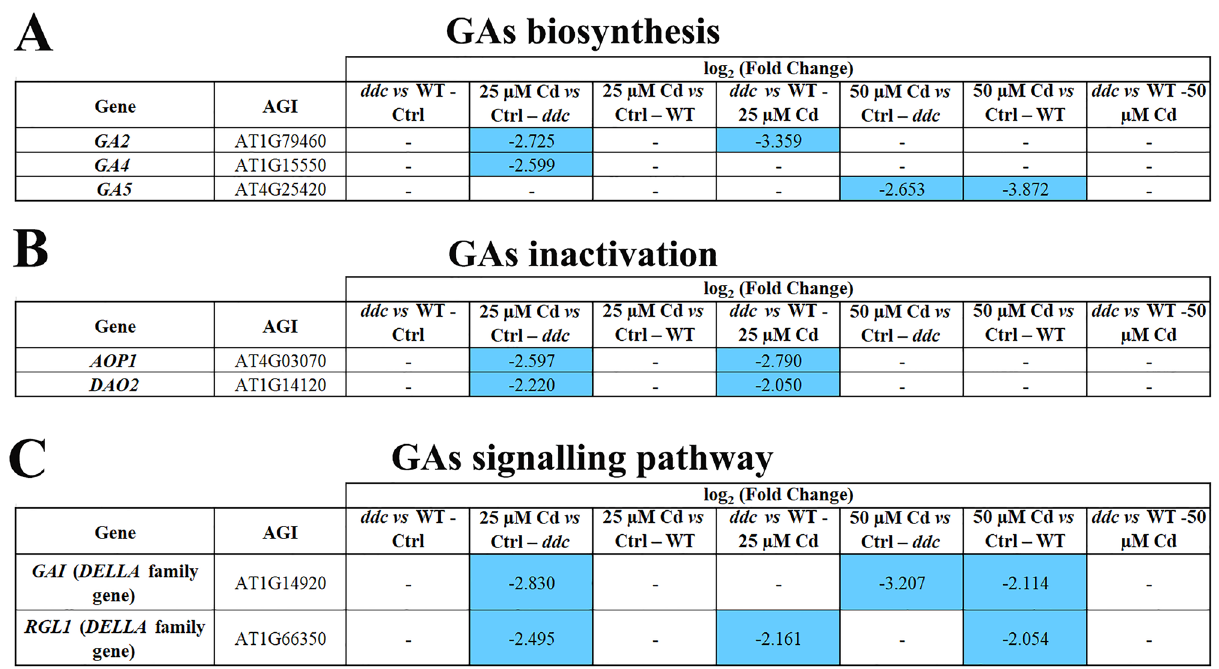
Figure 4. Genes differentially expressed (DEGs) along the pathway of ( A ) GAs biosynthesis, ( B ) GAs inactivation and ( C ) GAs signalling in ddc and WT plants identified through a transcriptomic approach. For each comparison, the log 2 (fold change) of the analysed DEGs was shown in orange and in blue for the upregulated and downregulated genes, respectively. Plants were grown for 21 DAG in long day condition: (i) on growth medium added with 25 or 50 µM Cd; (ii) on growth medium without Cd as control